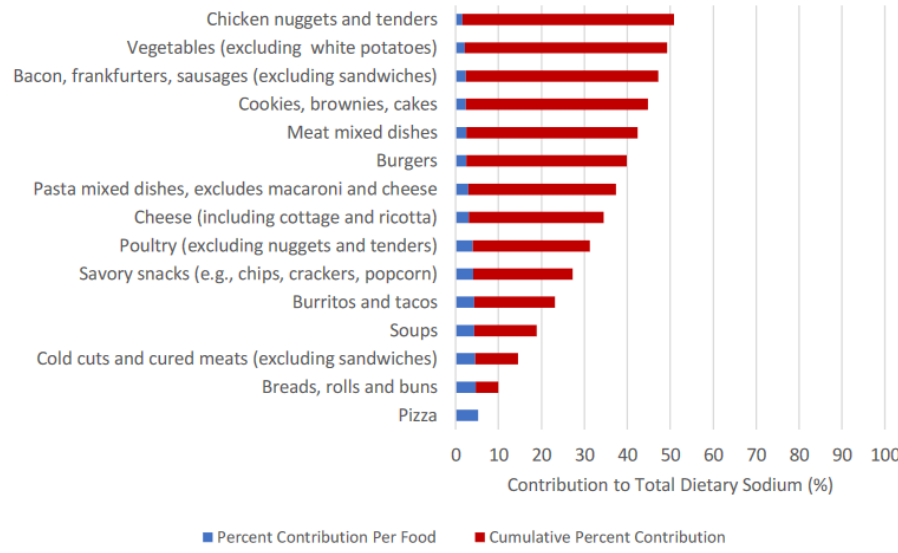
Figure 1. Percent Contribution and Cumulative Percent Contribution of Top 15 Food Categories Contributing to Sodium Intake.